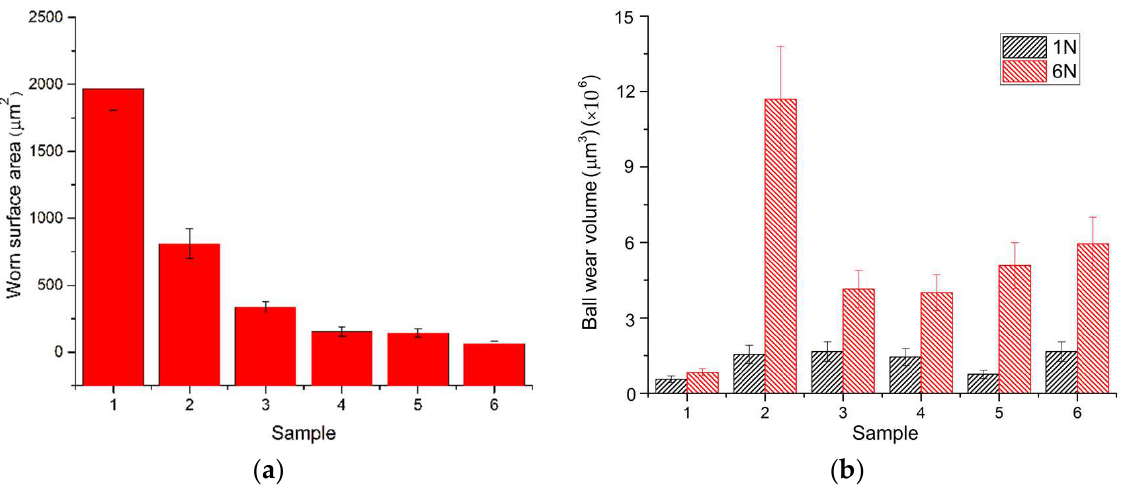
Figure 16. The wear track cross-section profile areas on coatings ( a ) and steel ball volume losses ( b ) resulted from sliding at 6N. Sample: 1—ZrN, 2—CrN, 3—ZrCrN(0.5), 4—ZrCrN(3.5), 5—ZrCrN(5) and 6—ZrCrN(8).